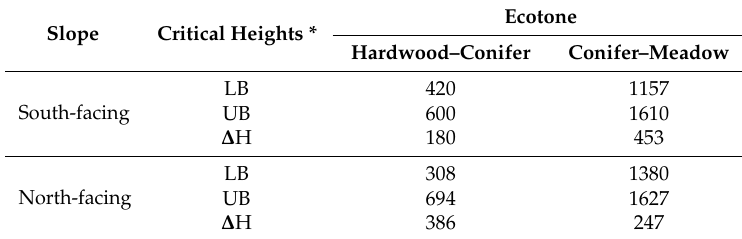
Table 1. Characteristics of the meadow and hardwood conifer ecotones